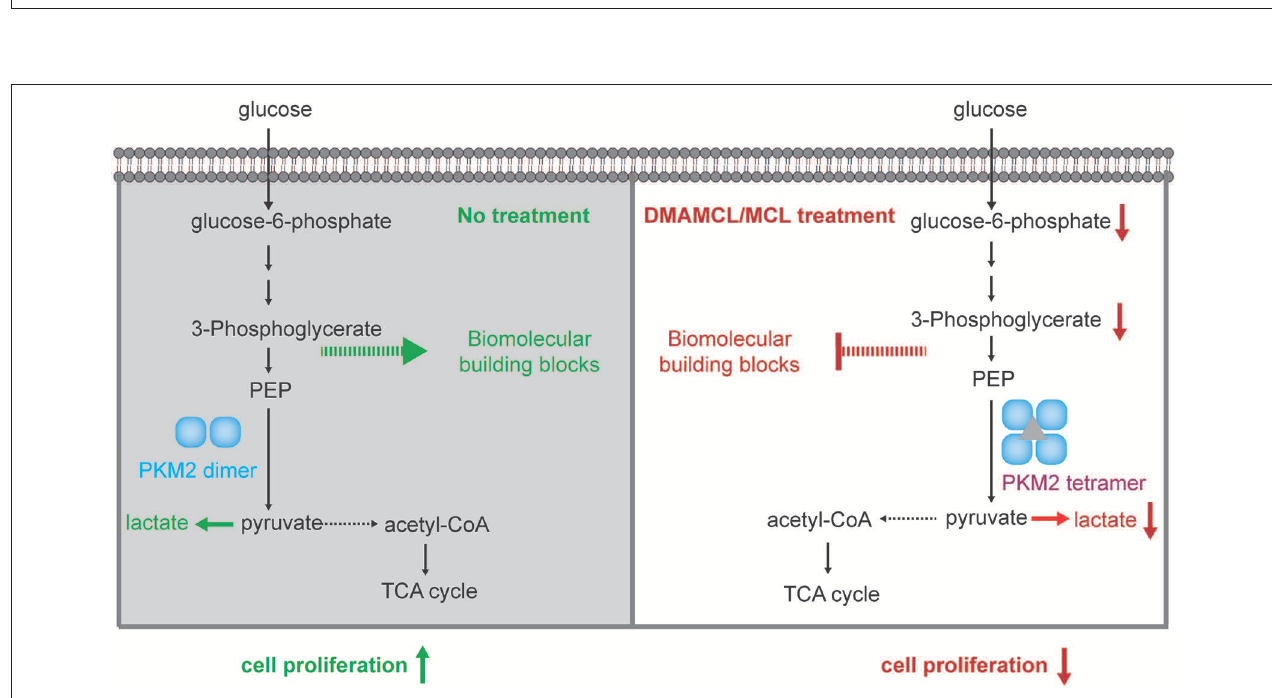
FIGURE 6 | The mechanism of DMAMCL and MCL on GBM inhibition through activating PKM2.